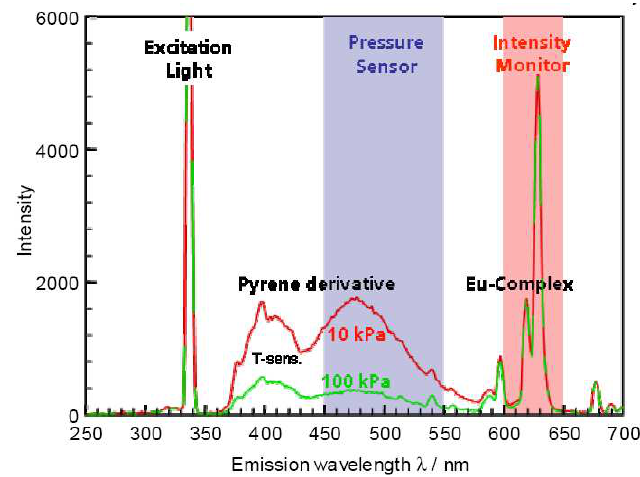
Figure 8. Typical emission spectrum of a typical binary PSP paint.